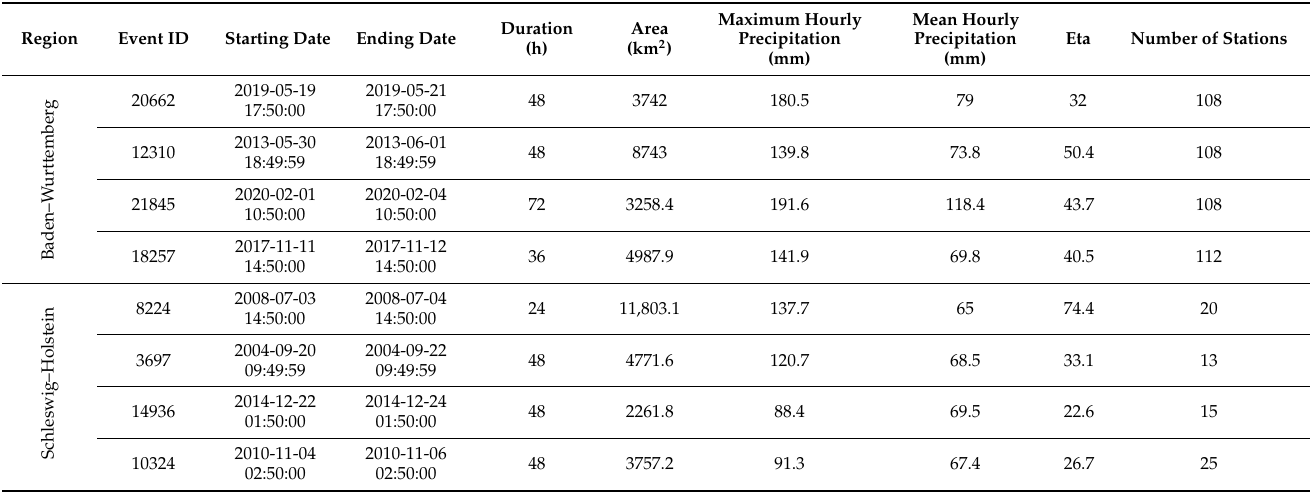
Table 1. Selected precipitation